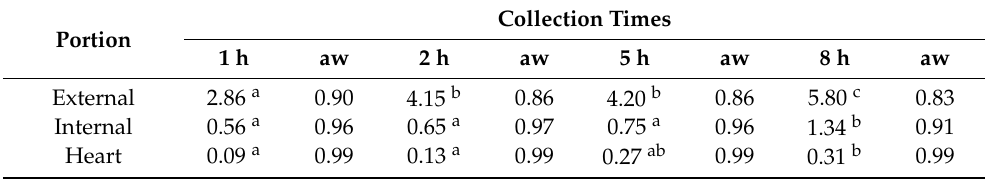
Table 2. NaCl concentration (%) in swordfish fillets after dry salting and storage for different times. Portion